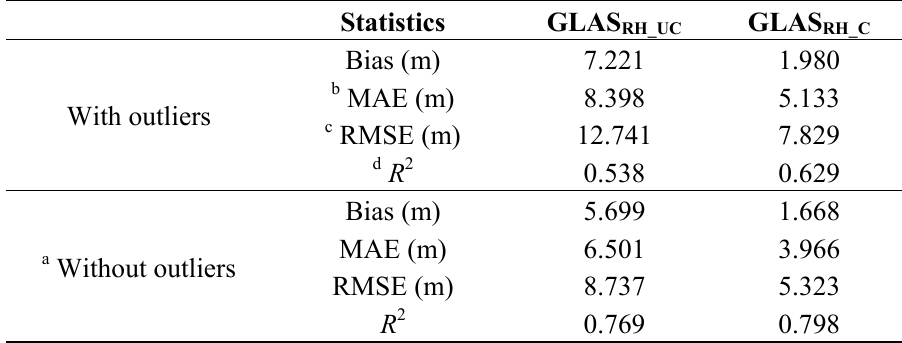
Table 5. Comparisons between uncorrected (GLAS GLAS